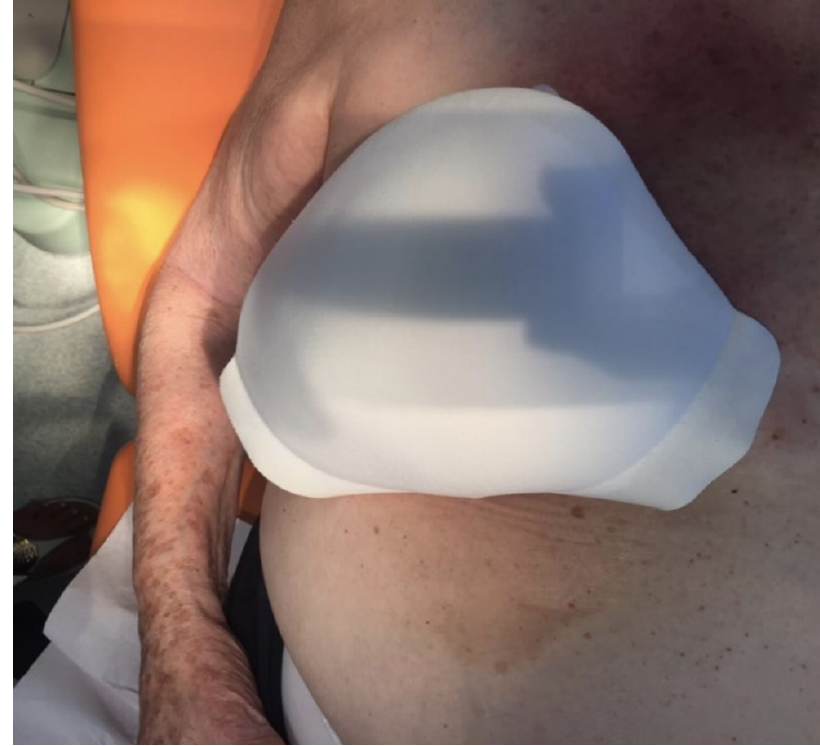
Figure 4. The gel device is applied again.